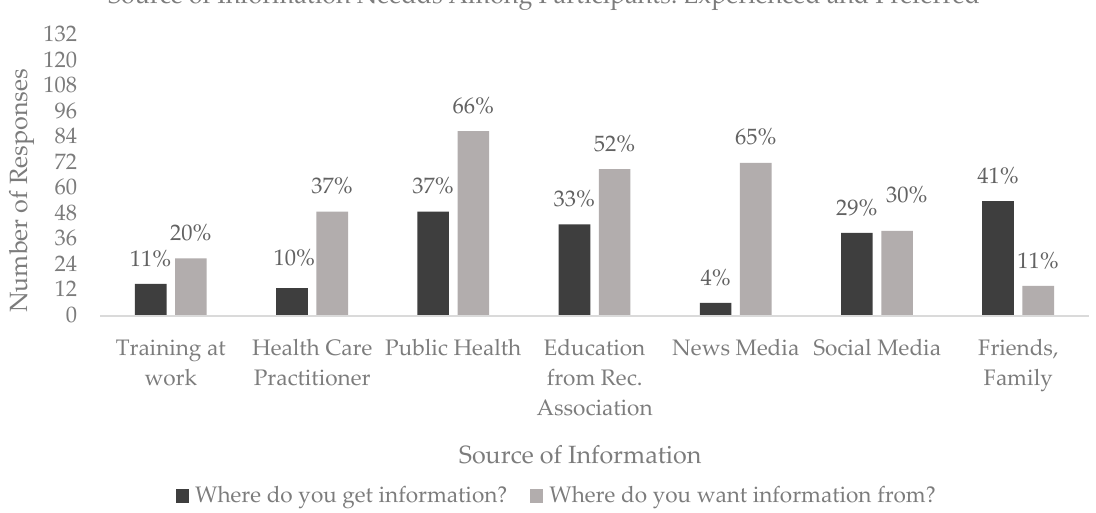
Figure 2. Where participants have accessed information regarding Lyme disease and where they would like to access information in the future.